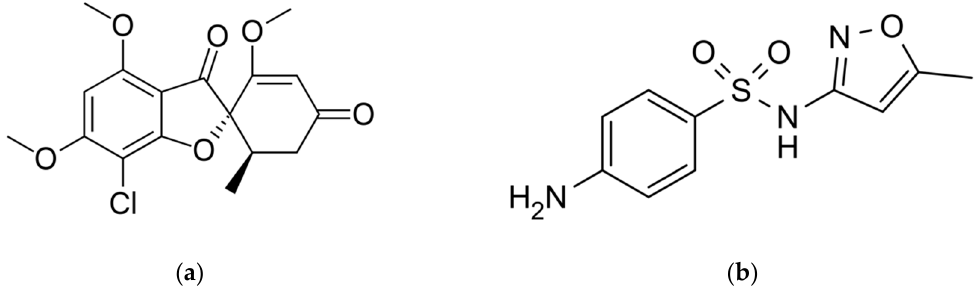
Figure 1. Structural formula for ( a ) griseofulvin (GF) and ( b ) sulfamethoxazole (SMZ).